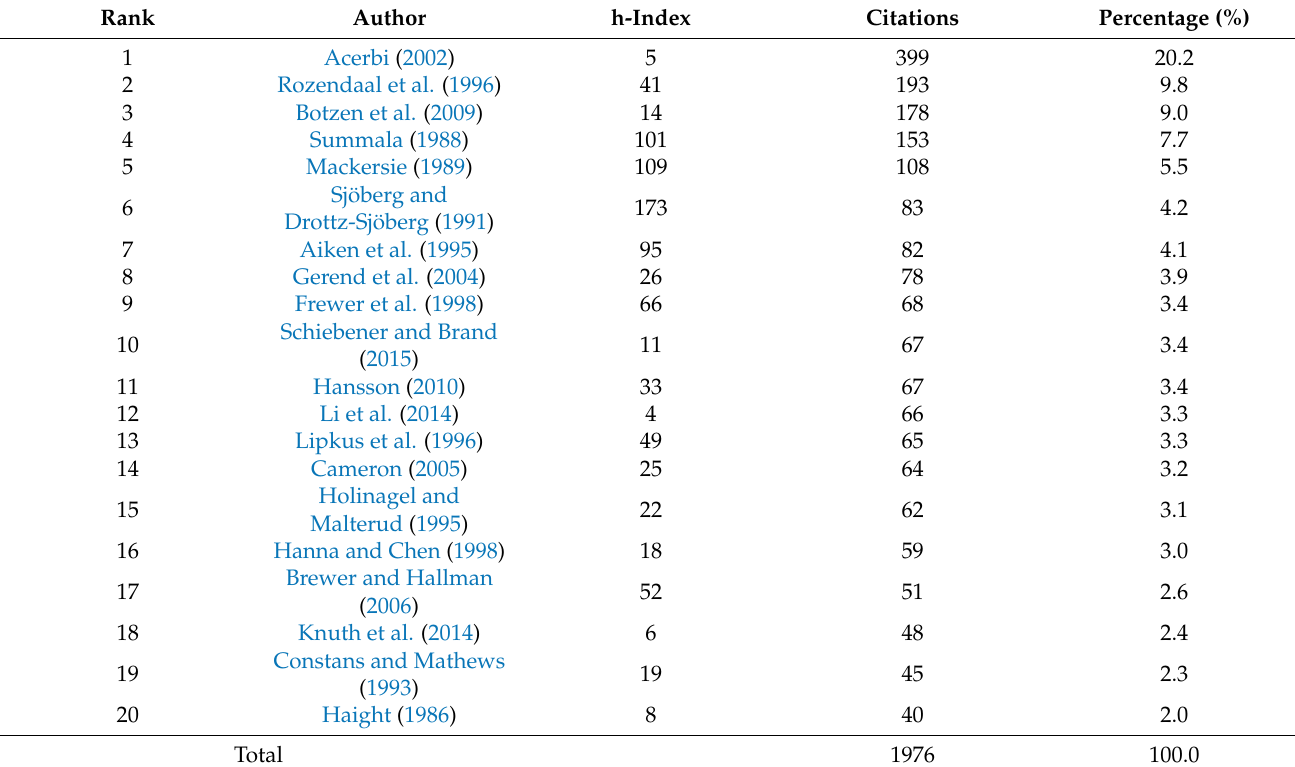
Table 3. Top 20 most cited documents on “objective risk” or “subjective risk”.